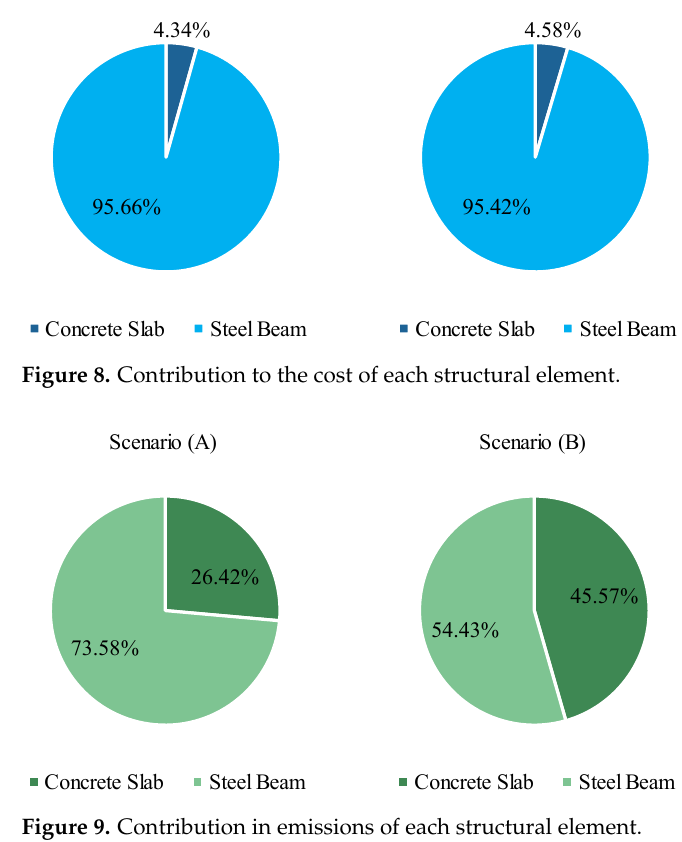
Figure 10. Average optimal values for design variables in each scenario * Values in the y axis divided by 10 ** Values in the y axis divided by 100 *** Values in the y axis multiplied by 10.